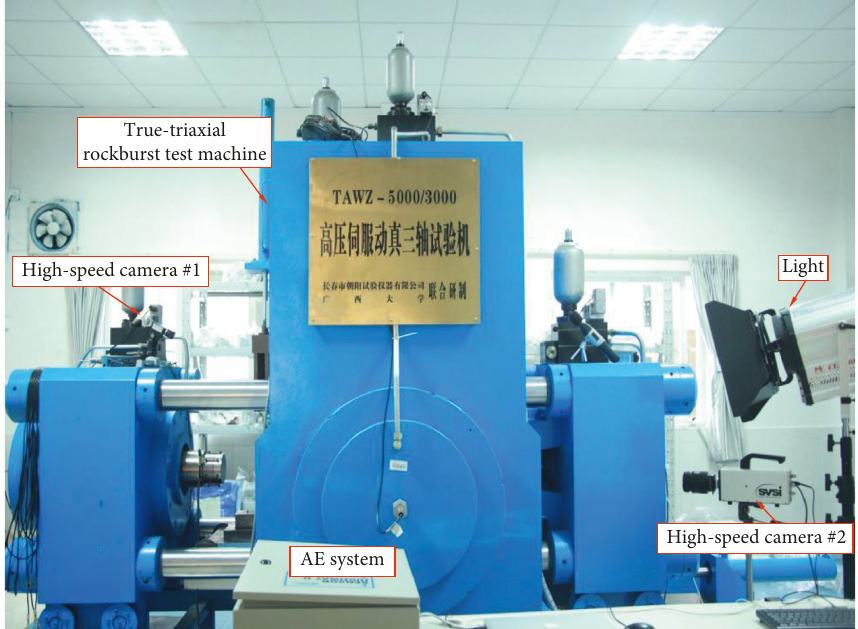
Figure 3: Illustration of the true-triaxial rockburst experimental system.